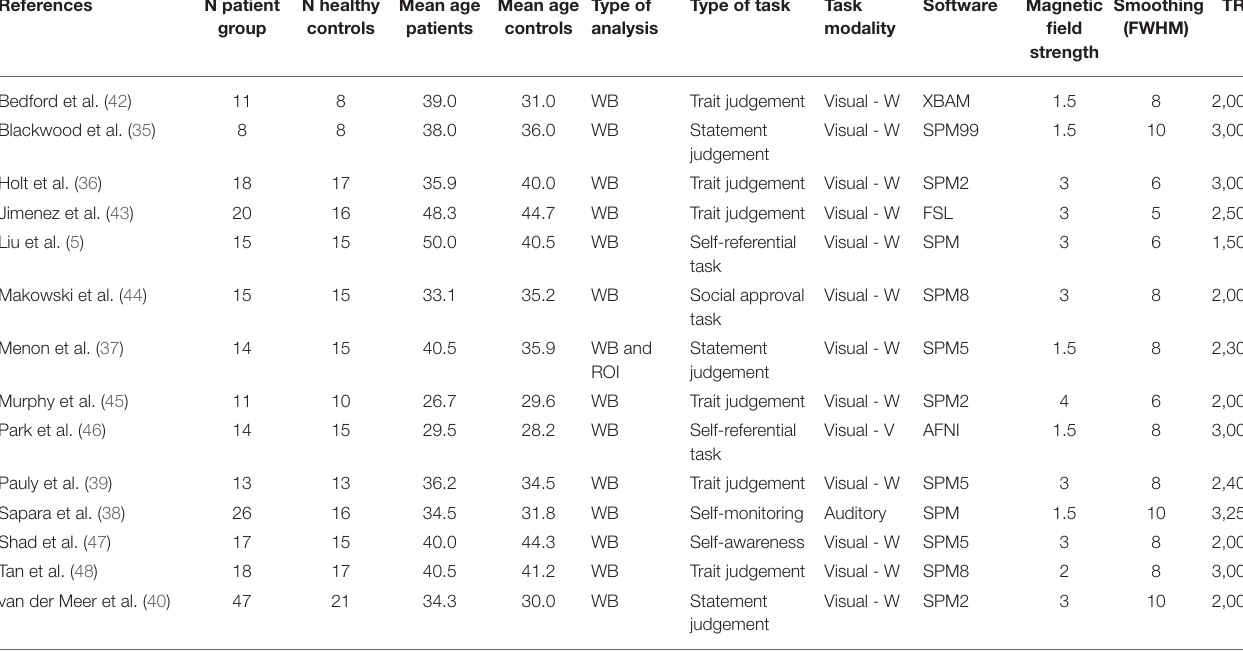
TABLE 1 | Description of studies included in the meta-analysis ( N =